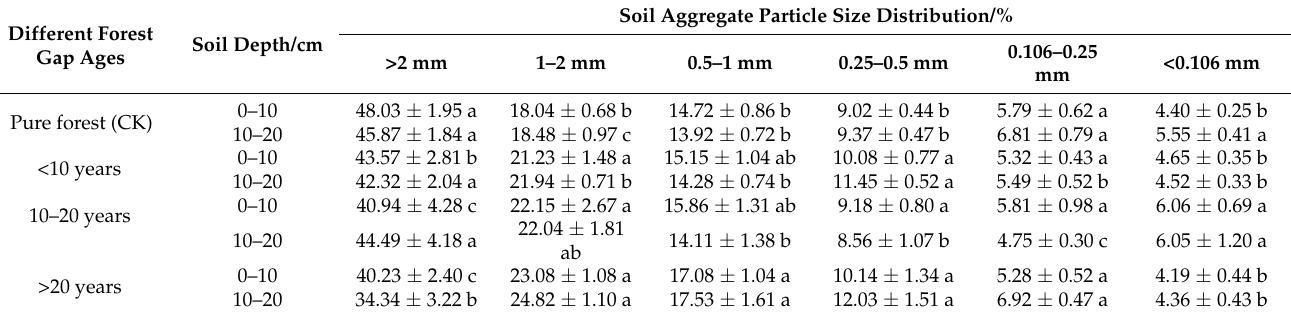
Table 3. Soil aggregate particle size distribution in forest gap of different